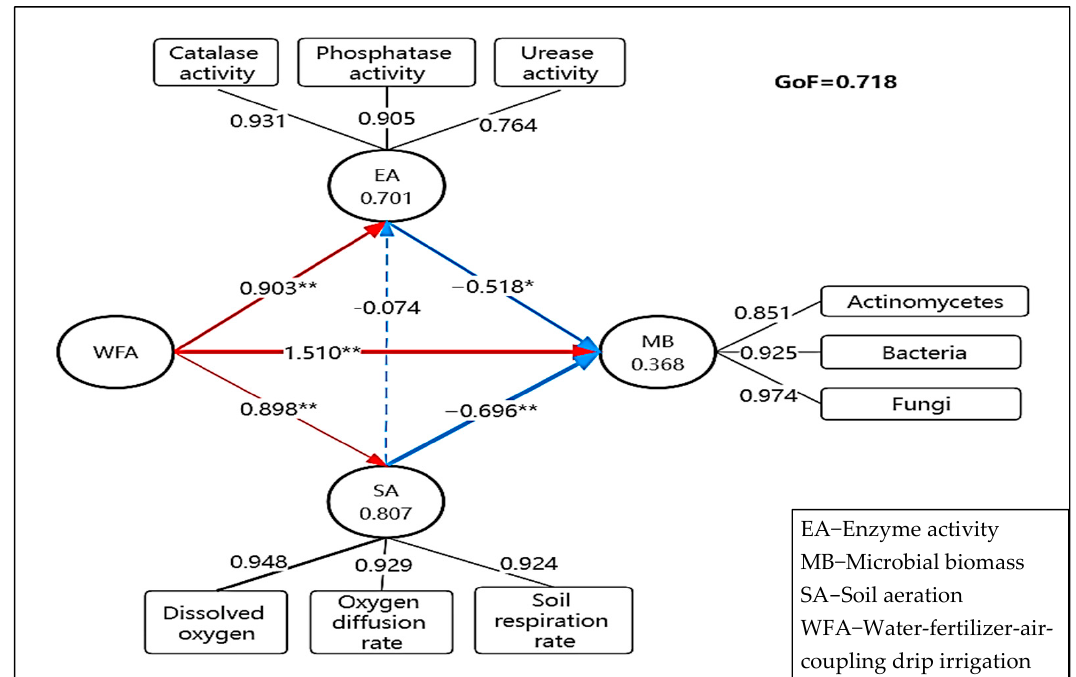
Figure 7. Influence path diagram of water-fertilizer-air-coupling drip irrigation on soil health status. Note: The value in the ellipse represents the determination coefficient R 2 value, the ellipse represents the latent variable, the box represents the observed variable, the red arrow indicates a significant positive effect, the blue arrow indicates a significant negative effect, the arrow line thickness indicates the size of the path coefficient in the model, and the dotted line indicates no significant effect. The value on the real line between the latent variable and the observed variable represents the external load value, * p < 0.05. ** p < 0.01.